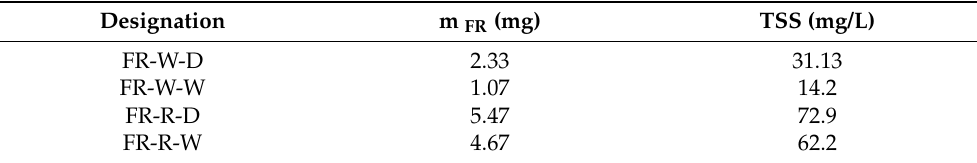
Table 2. Average values of total suspended substances, TSS, and mass of FRs.